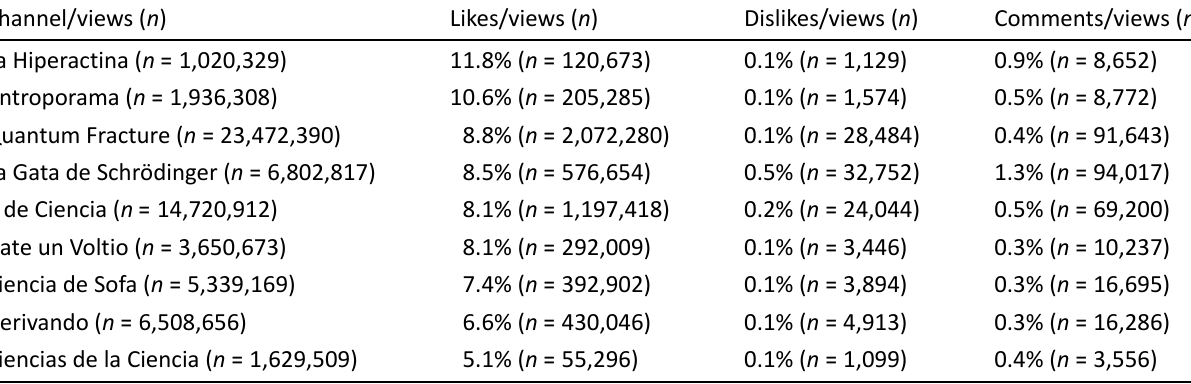
Table 3. Percentage of views vs. likes, dislikes, and comments per channel (2019–2020). Channel/views ( n